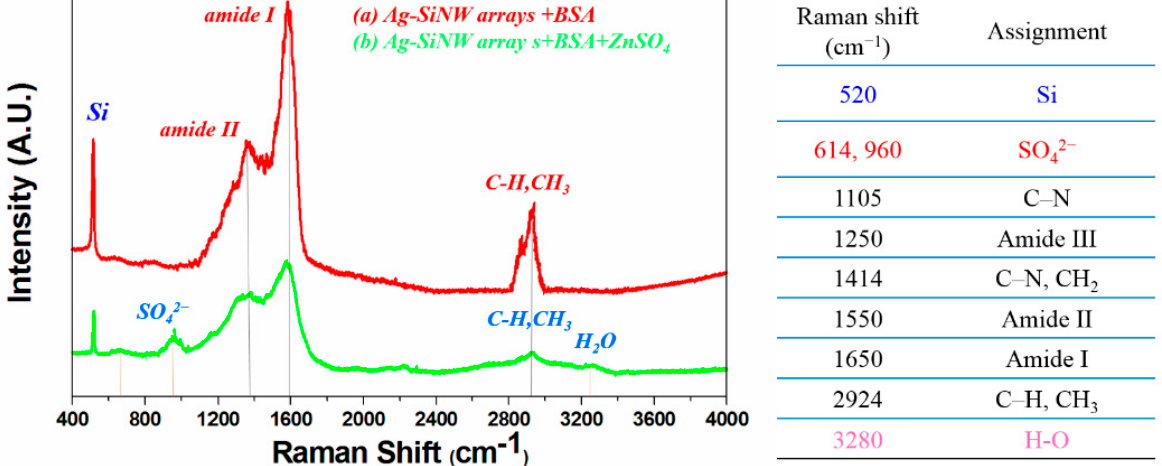
Figure 10. Comparison of SERS spectra of ( a ) the Ag–SiNW arrays immobilized with BSA (red line) and ( b ) the Ag–SiNW arrays immobilized with BSA and ZnSO 4 (green line).